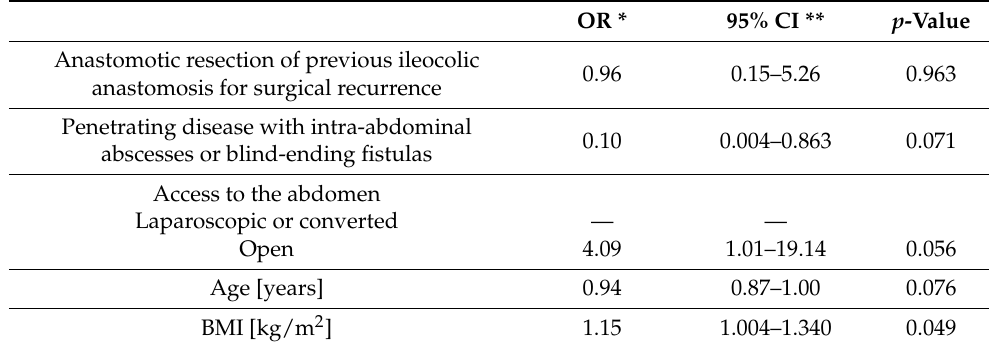
OR * 95% CI ** p -Value 0.96 0.10